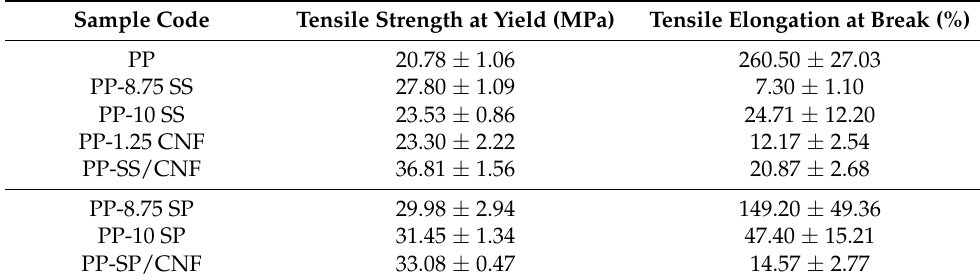
Figure 7. Mechanical properties of ( a ) stress-strain curves of PP composites and ( b ) an enlarged graph. Table 3. Mechanical properties PP